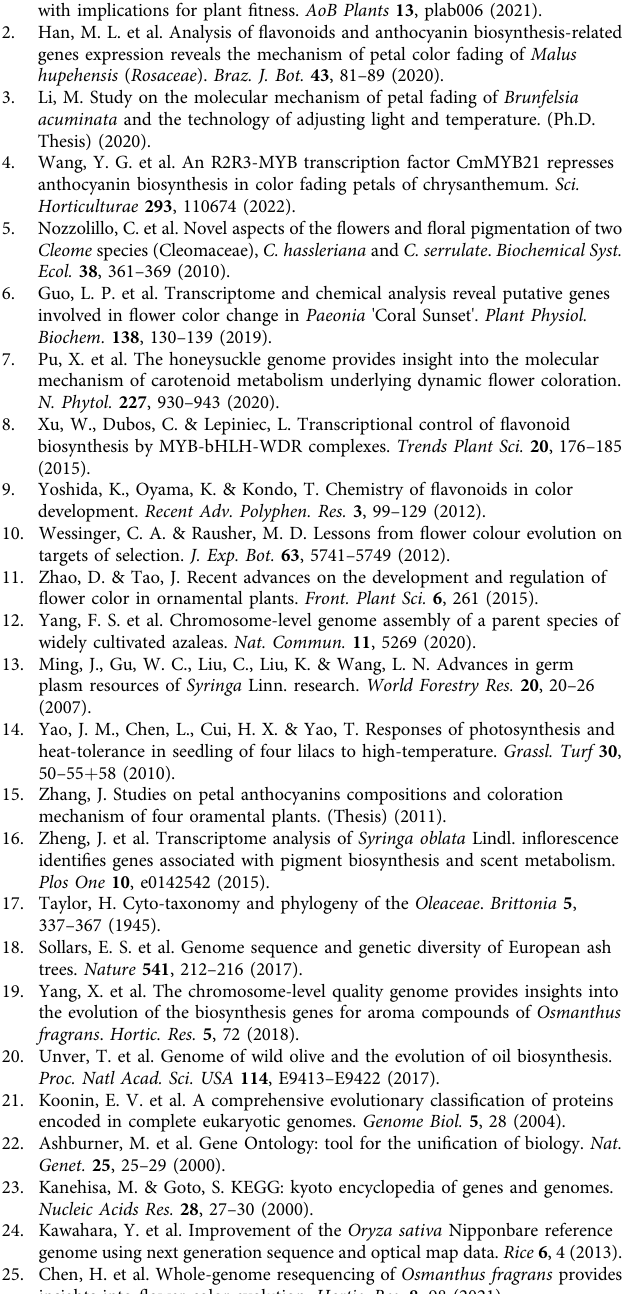
Statistics and reproducibility . In Fig. 4b, Supplemental Figs. 10 – 12, and Sup- plemental Fig. 19, we used n = 3 biologically independent samples. Statistical analyses of metabolites relative contents and qRT-PCR were performed with GraphPad Prism 8. All the values were given as the mean ± SE and were analyzed by one-way ANOVA with multiple comparisons between adjacent stages ( * p < 0.05, ** p < 0.01, *** p < 0.001, **** p <